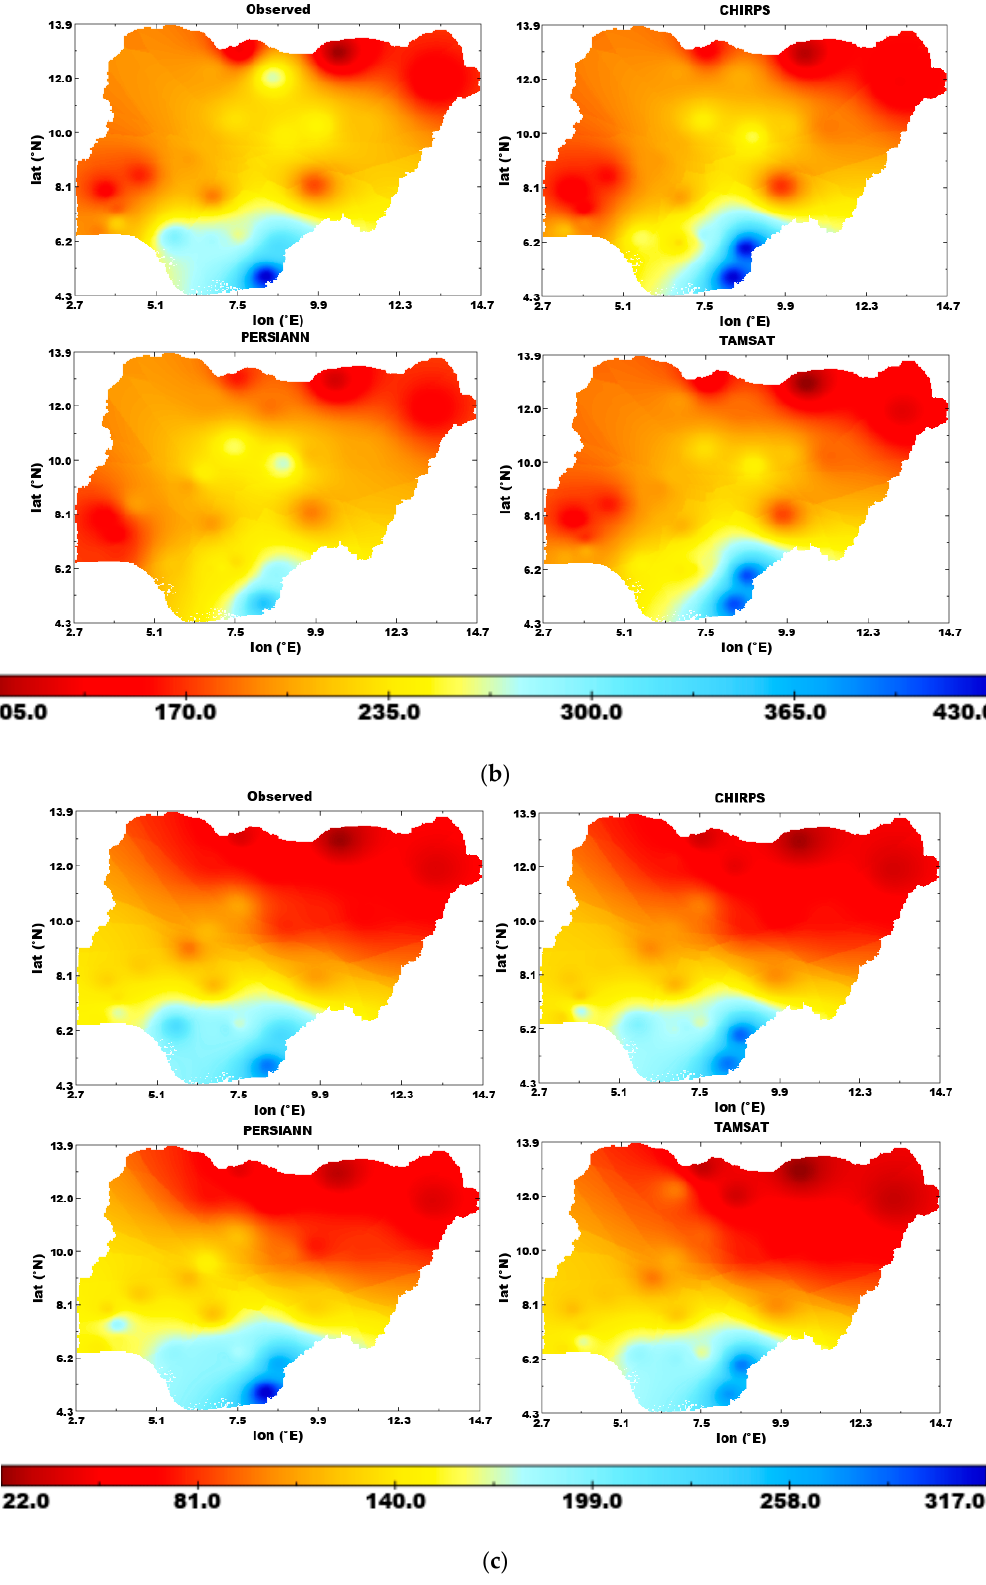
Figure 2. ( a ) Spatial distributions ofMarch–May (MAM) mean rainfall (mm/month) over Nigeria; ( b ) Figure 2. Spatial distributions of mean seasonal rainfall amount (mm / month) for ( a ) MAM, ( b ) JJA, Spatial distributions of June–August (JJA) mean rainfall (mm/month) over Nigeria; ( c ) Spatial and ( c ) SON over distributions of September–November (SON) mean rainfall (mm/month) over Nigeria.